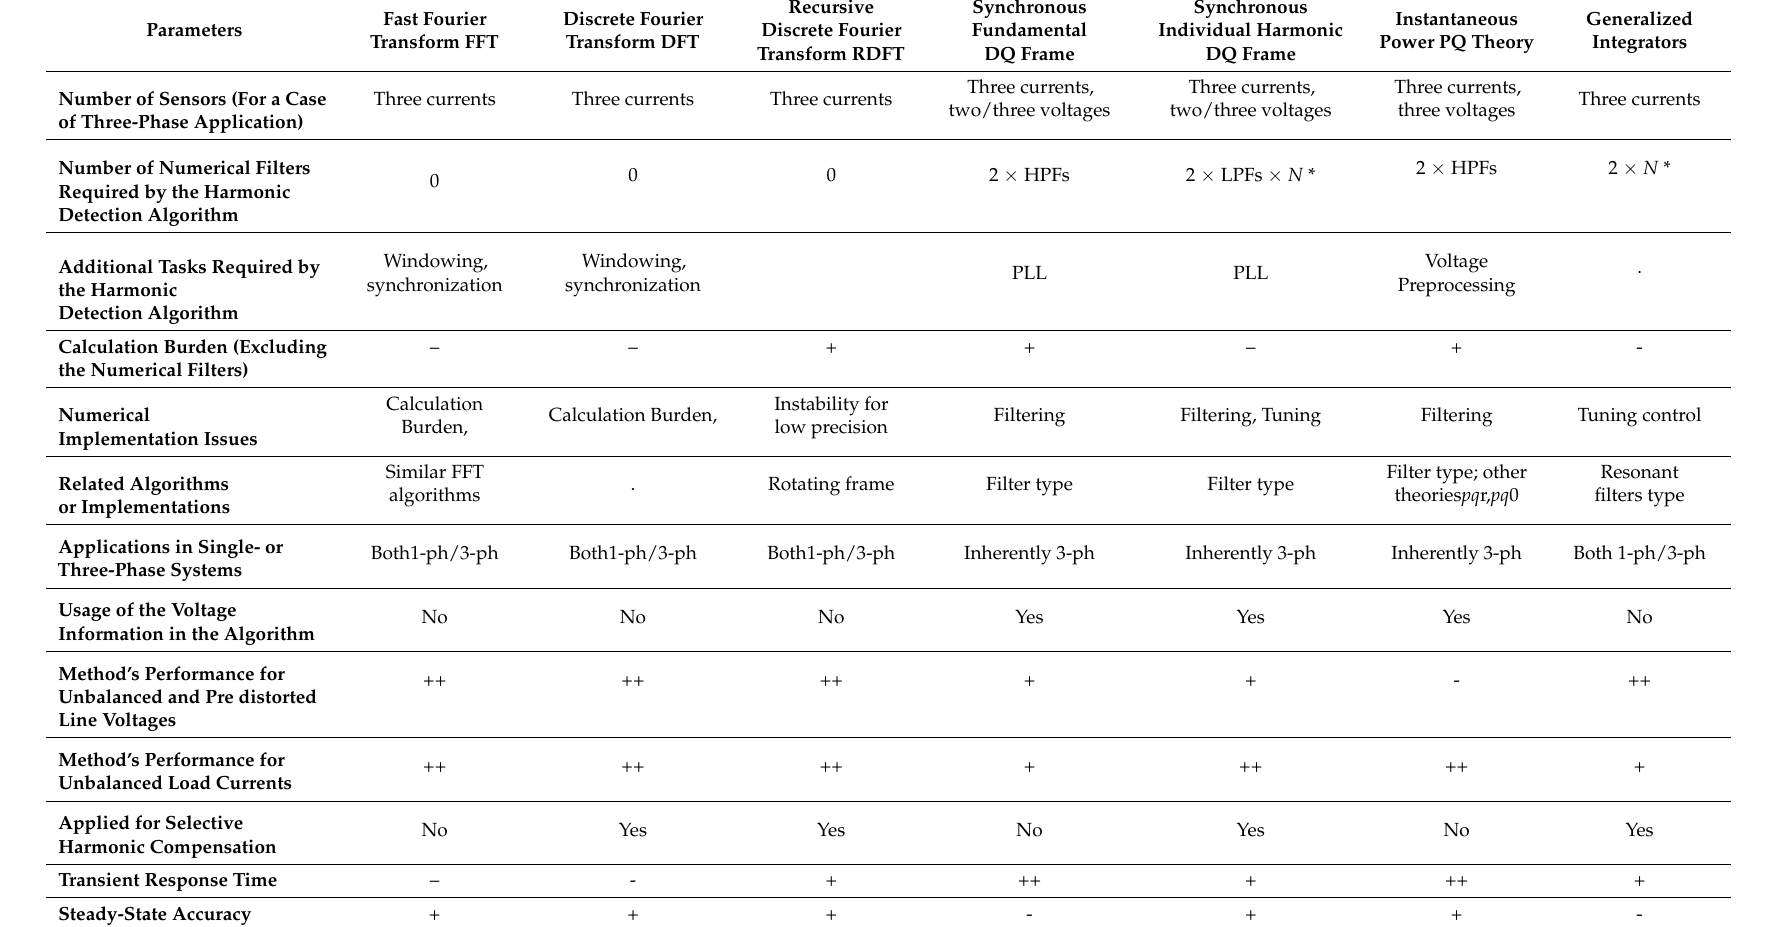
Table 9. Evaluation of harmonic detection